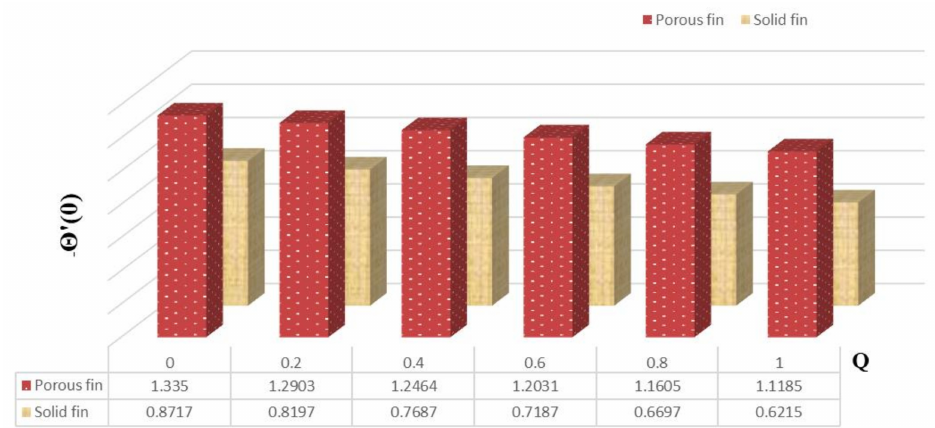
Figure 4. Heat flux of porous and solid